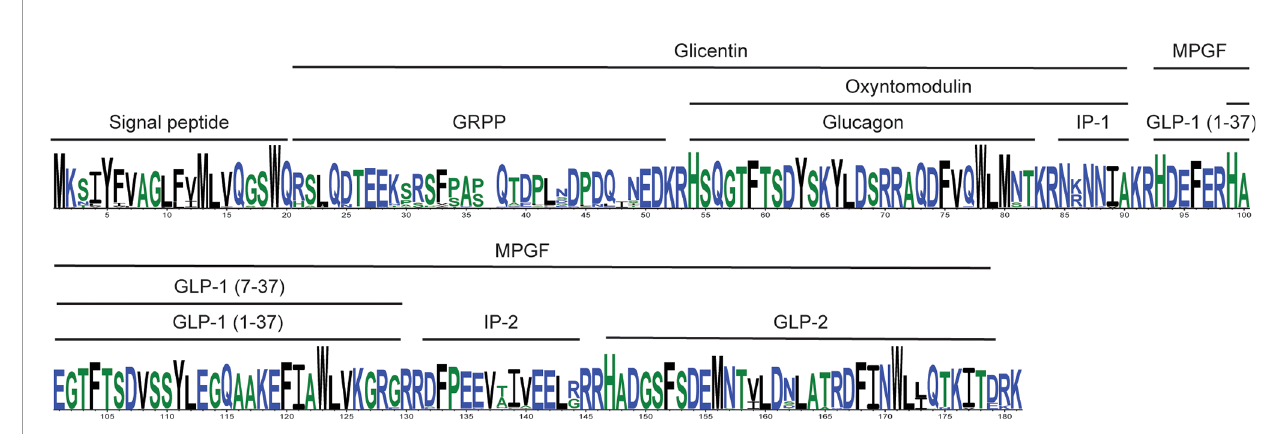
FIGURE 2 | Summary of the alignment of mammalian proglucagon amino acid sequences. Consensus amino acid sequence for proglucagon encoded by mammalian Gcg genes. The consensus sequence was generated from aligned predicted protein sequences (see Supplementary Figure 5 ) of mammalian genes with complete open reading frames using WebLogo 3 (57). Hight of the residue is proportional to representation among the compared sequences, while residue width represents proportion of sequences without a gap (thin residues are gaps in many sequences). The locations of the different proglucagon-derived peptides are indicated by the bars above the